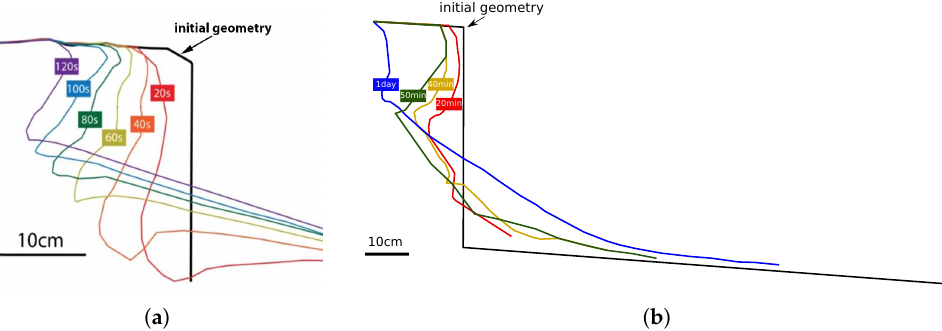
Figure 6. Development of the breach face showing nonuniform erosion along the sand–water interface: ( a ) breach height = 30 cm, D 50 = 140 µ m (adapted from [63], with the permission from You, Y. 2013); ( b ) breach height = 70 cm, D 50 =70 µ m (adapted from [64], with the permission from Eke, E.C.